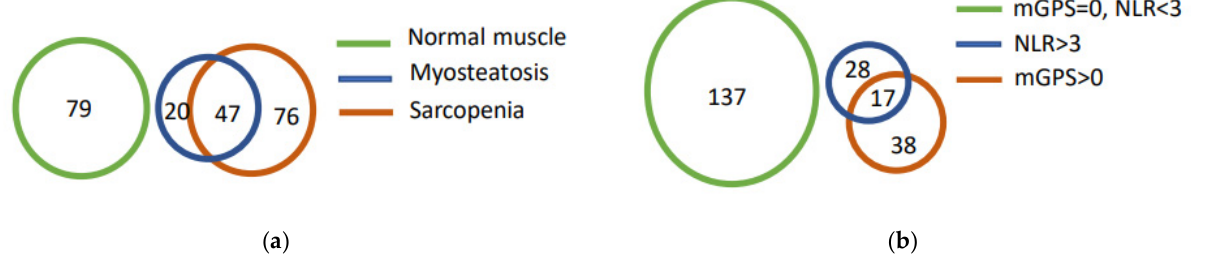
Figure 1. ( a ) Diagram of body composition parameters in CRC patients. In total, 47 patients had